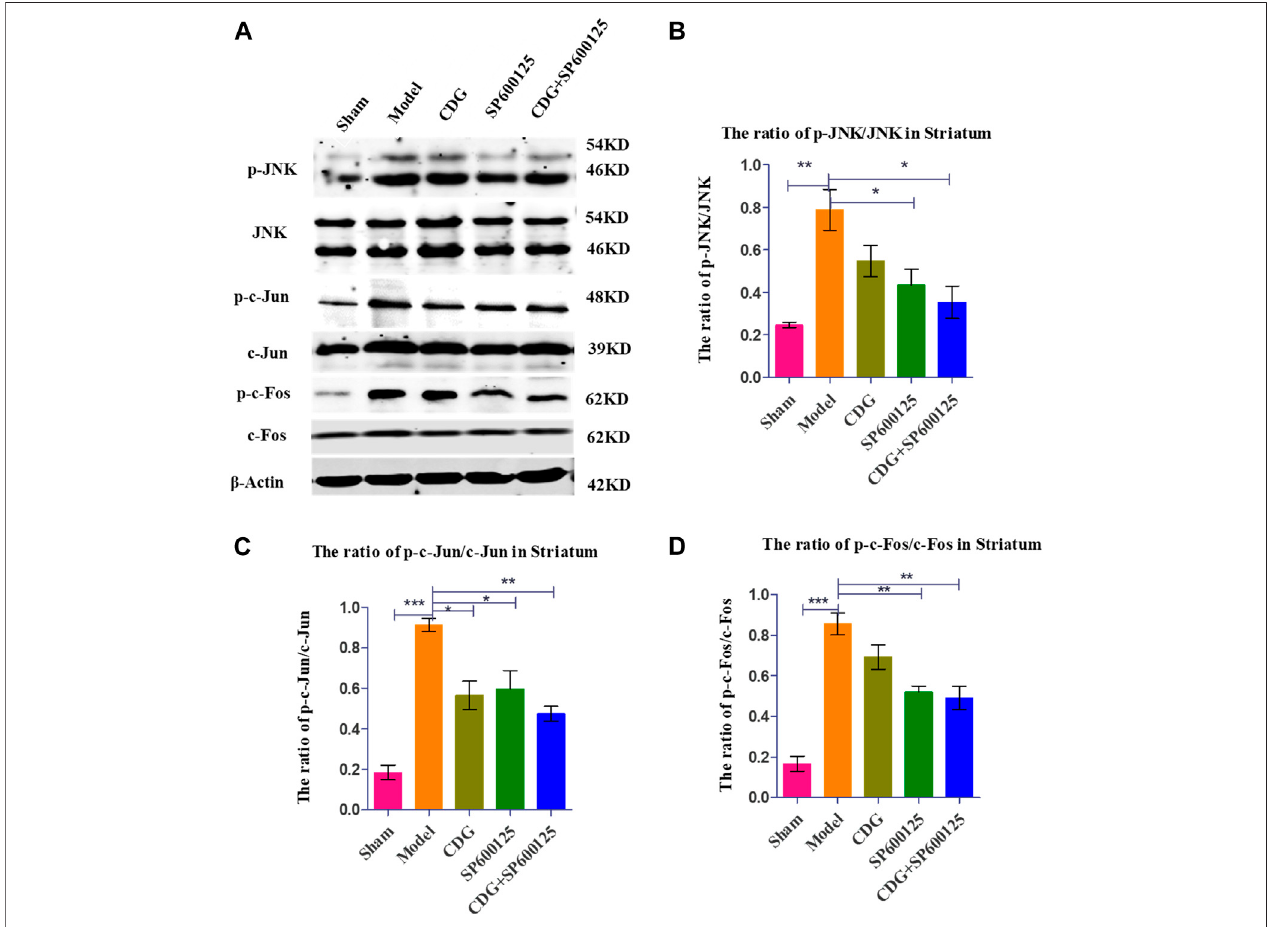
FIGURE 9 | Inhibition of related protein expression in the JNK/AP-1 signaling pathway. (A) The expression levels ofp-JNK, JNK, p-c-Jun, c-Jun, p-c-Foc, and c-Fos were detected with Western Blot in the striatum. (B – D) The expression levels of p-JNK/JNK, p-c-Jun/c-Jun were calculated. GAPDH served as control. Statistical analysis was performed with One-Way ANOVA, Turkey ’ s multiple comparison test, post hoc, n (cid:1) 3. Signi fi cant differences were indicated by * p < 0.05, ** p < 0.01, *** p < 0.001.